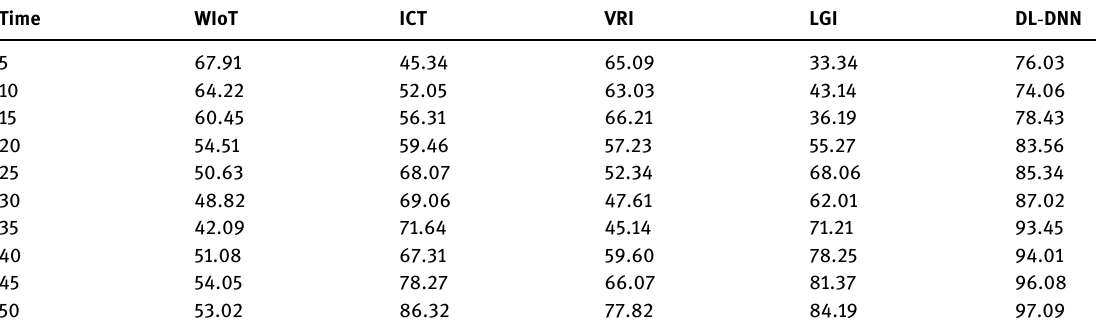
Table 1: Judgment rate ( %